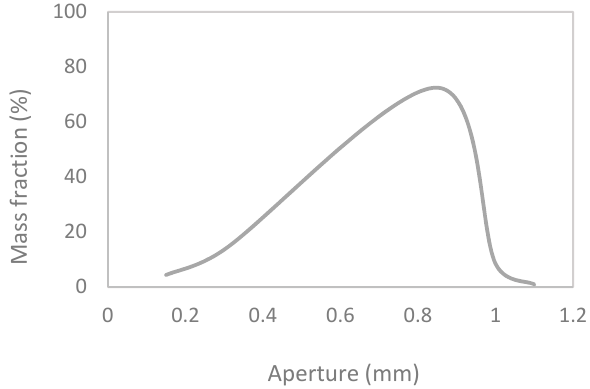
Figure 1. Particle size distribution of grounded rice straw.